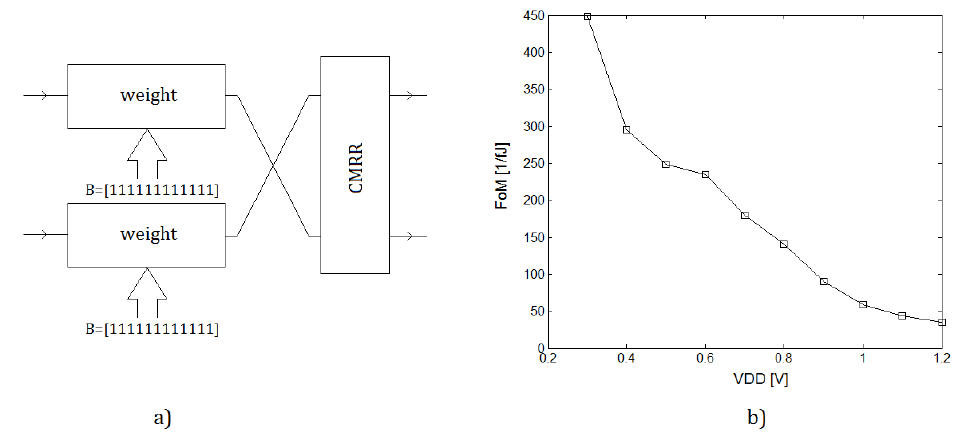
Figure 4. FoM parameter: ( a ) the analyzed circuit, ( b ) dependence of FoM on the supply voltage VDD.